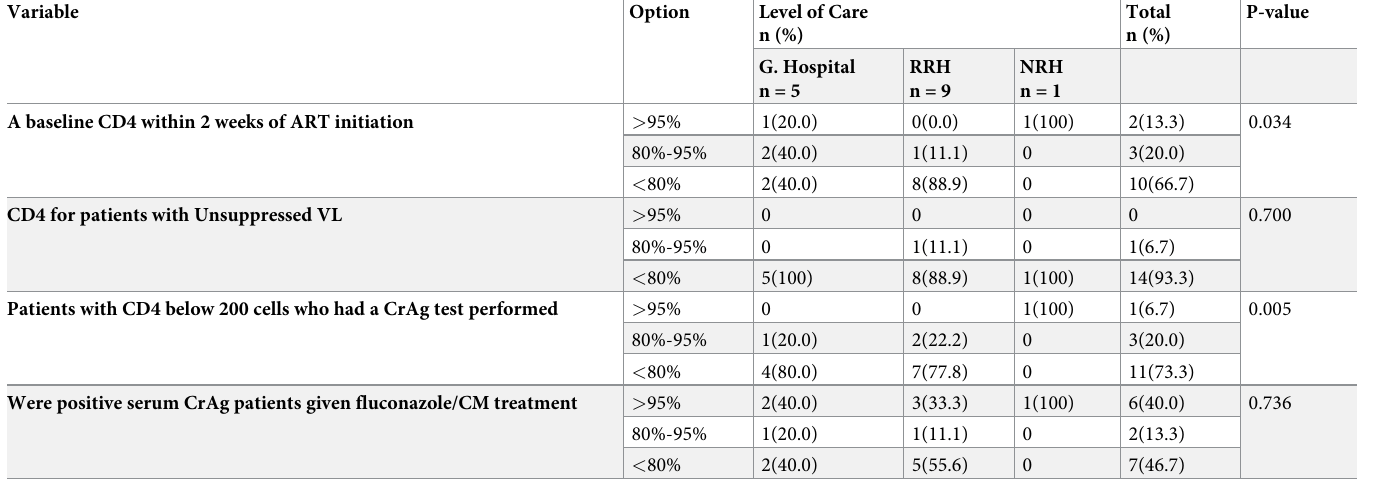
Table 2. Standards of screening of HIV positive patients with CD4 below 200 cells.